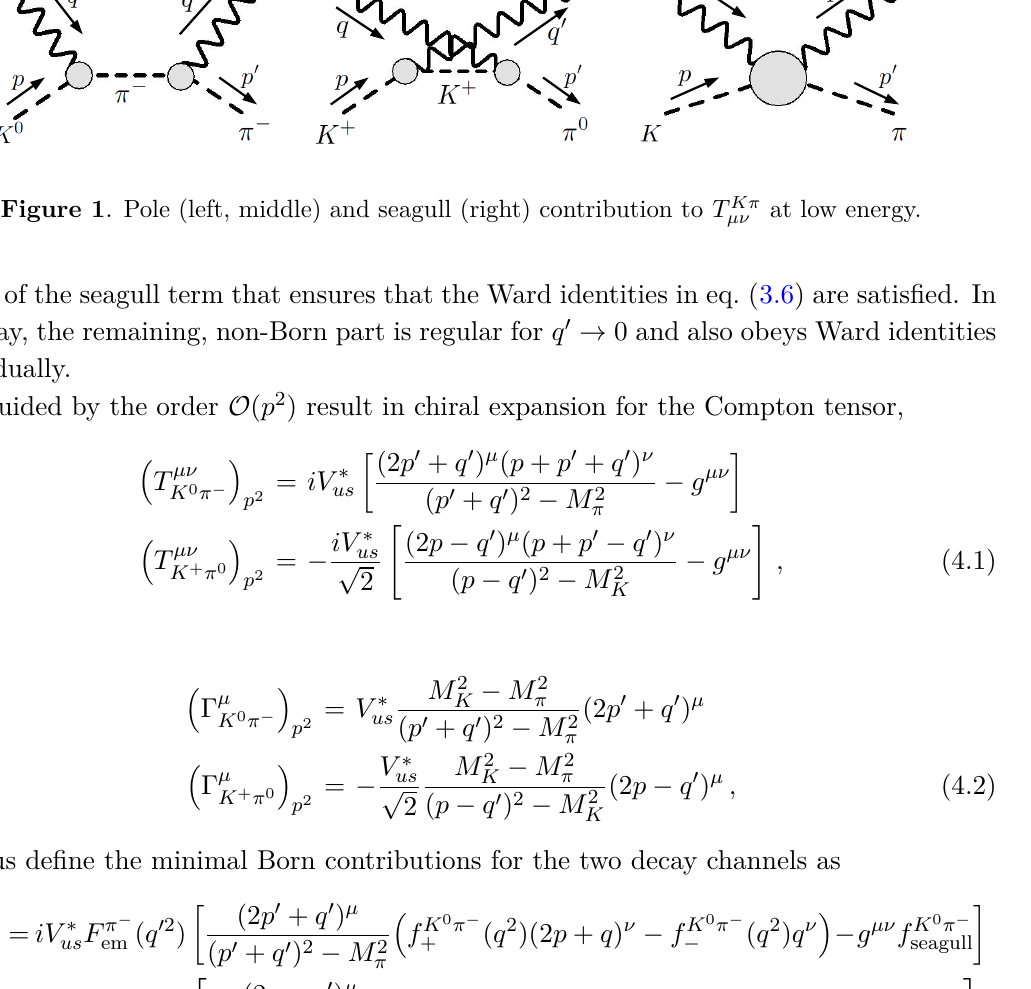
Figure 1 . Pole (left, middle) and seagull (right) contribution to T Kπ